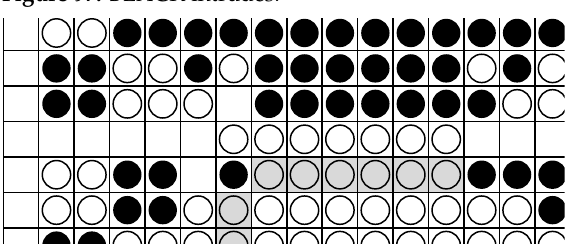
Figure 98. BLACK